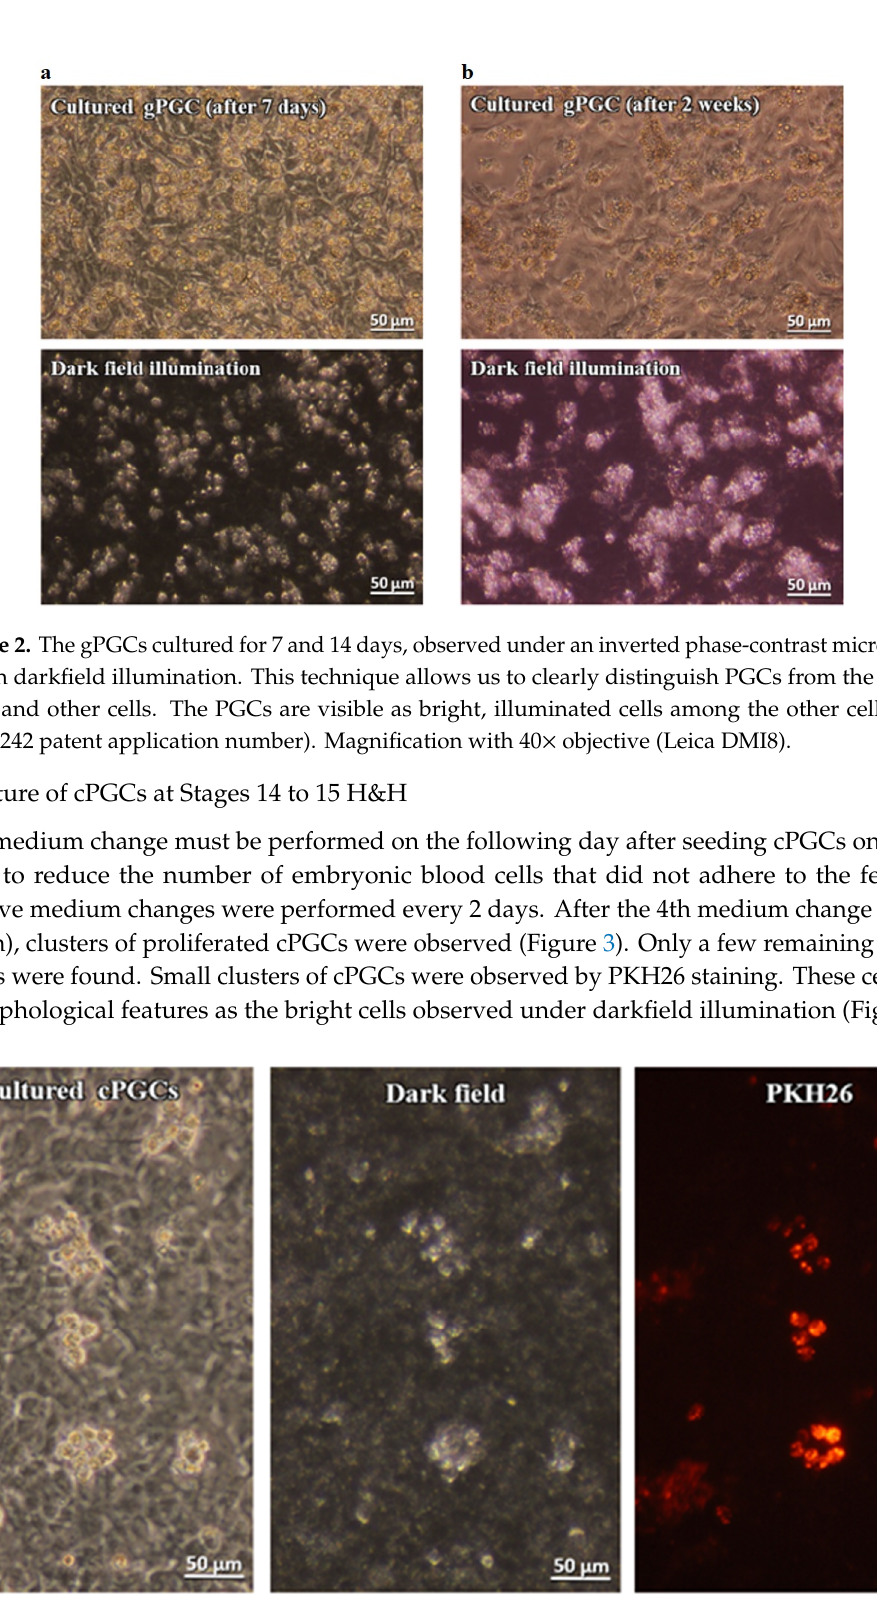
Figure 3. The cPGCs cultured for 7 days observed under an inverted phase-contrast microscope and darkfield illumination (P.434242 patent application number). The cells were stained after 7 days of culture using PKH26 fluorescent dye. Magnification of the objective 40× (Leica DMI8).